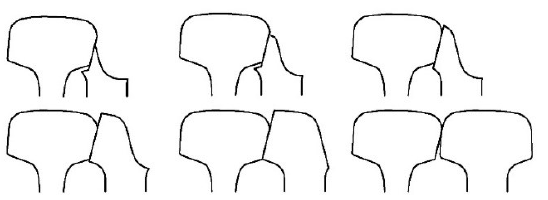
Figure 2. Part of the profiles of the rail with a variable cross-section.